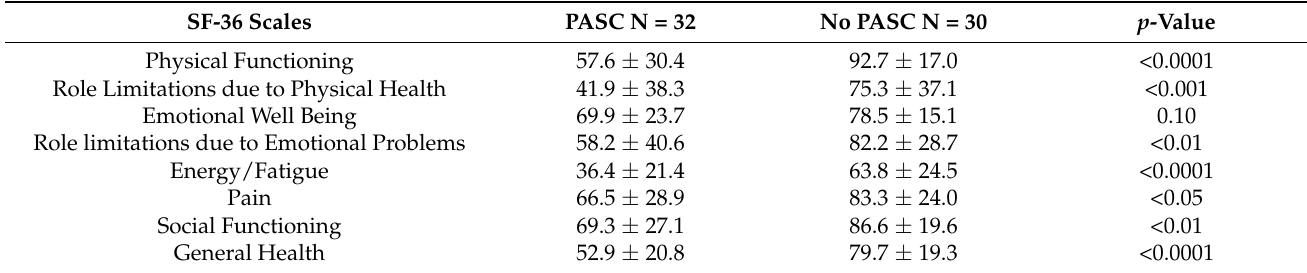
Table 4. Comparison of SF-36 scores from participants with and without post-acute sequelae of COVID-19